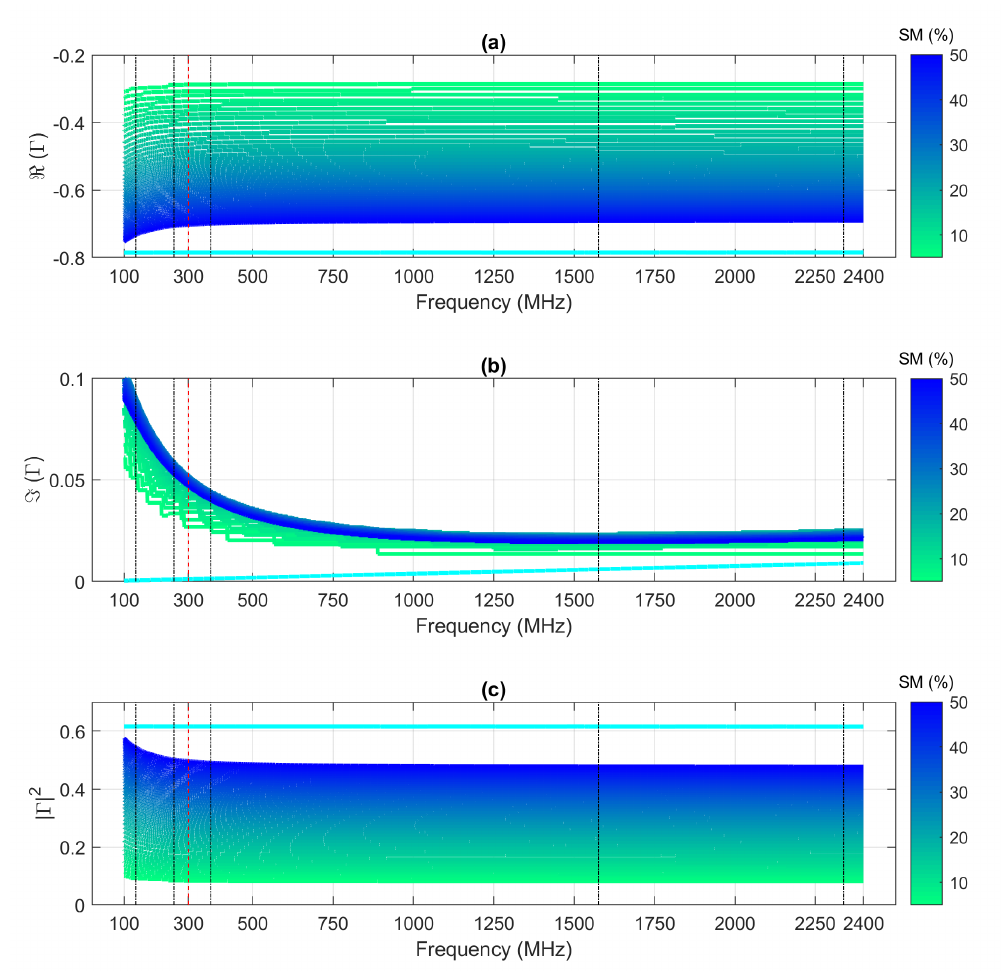
Figure 3. ( a ) Real, ( b ) imaginary, and ( c ) magnitude square of the measured reflection coefficient. The color gradient shows the reflection coefficient values for soil moisture between 5% and 50%, and the cyan line shows the reflection coefficient values of water for the given frequency range. The black, dashed lines show the position of the commonly referenced SoOp-R sources, while the red dashed line shows the lower validation region of the Mironov dielectric model. All measurements are performed at normal